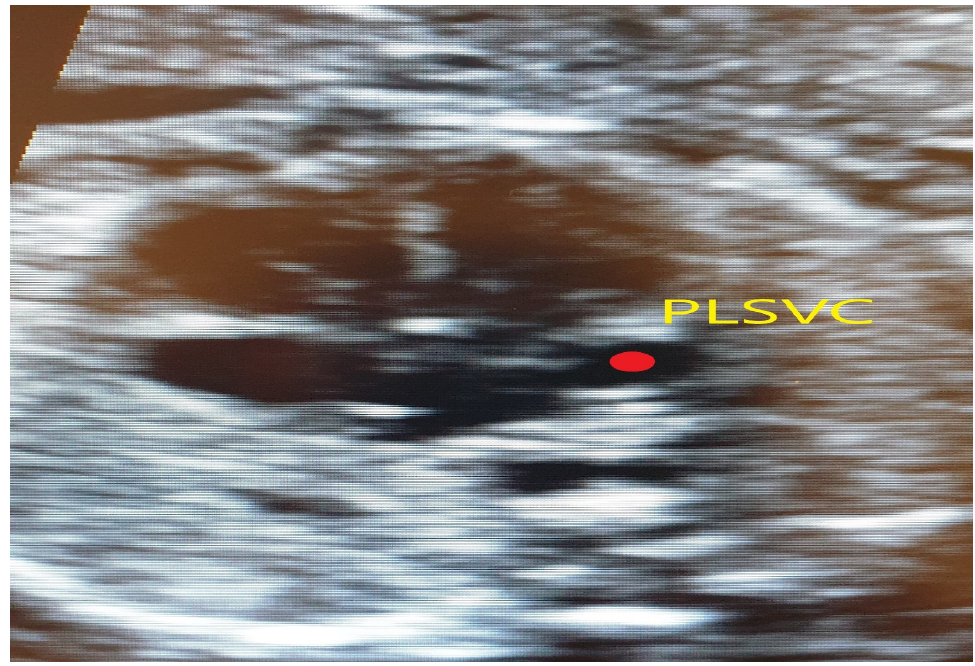
Figure 12. The same case as above; dilated coronary sinus. Persistent left superior vena cava